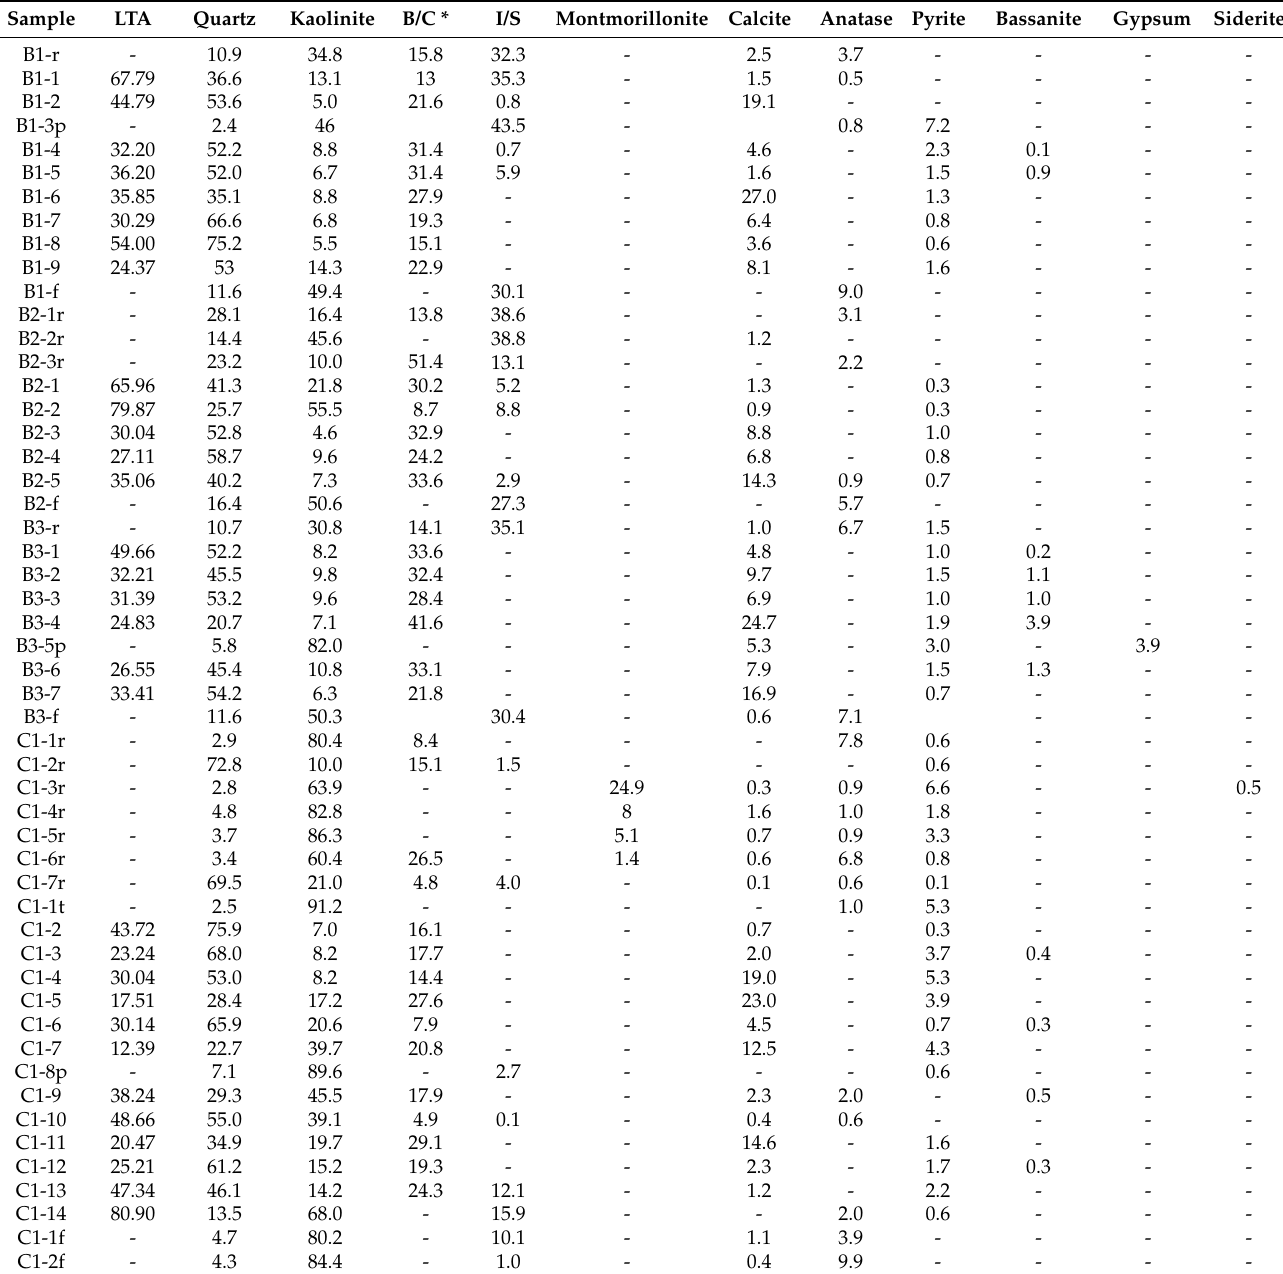
Table 2. Low-temperature ash (LTA) yields of coal samples and mineral contents in coal LTAs, partings, and roof and floor strata samples determined by X-ray diffraction (XRD) and Siroquant (%, on organic matter-free basis).